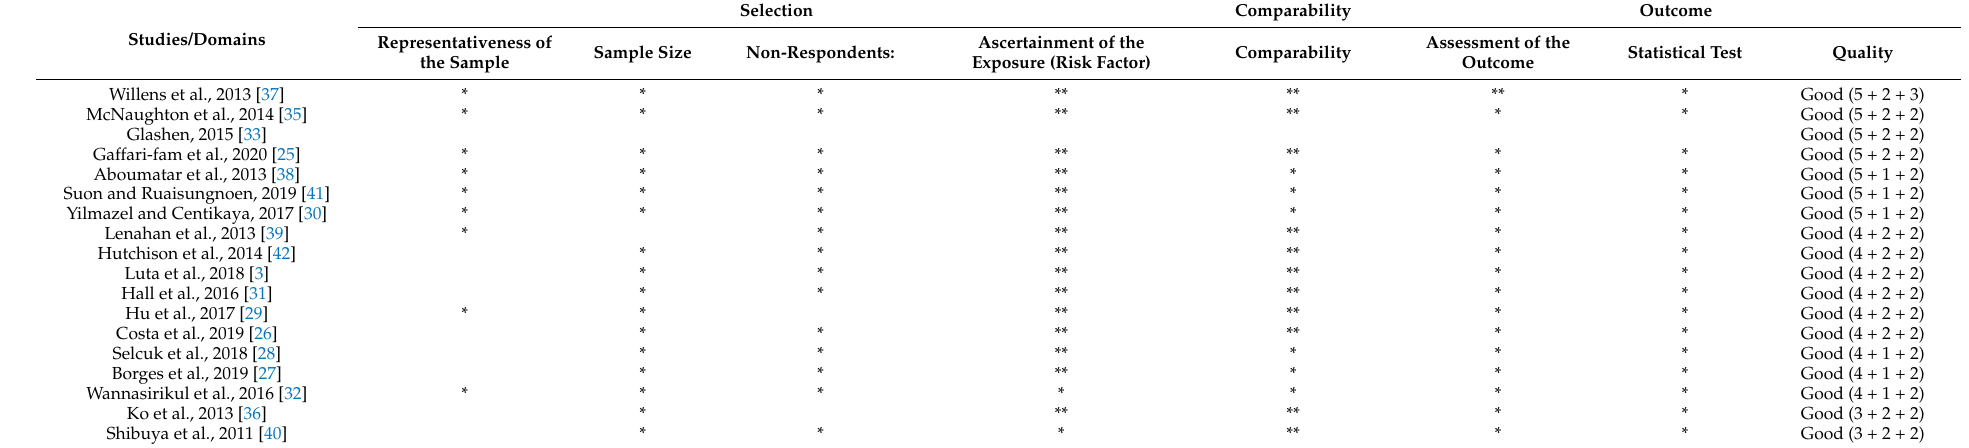
Table 4. Summary of Quality Assessment of the included studies using the Newcastle–Ottawa Quality Assessment Scale (adapted for cross-sectional studies). Selection Comparability Outcome Studies/Domains Representativeness of the Sample Sample Size Non-Respondents: